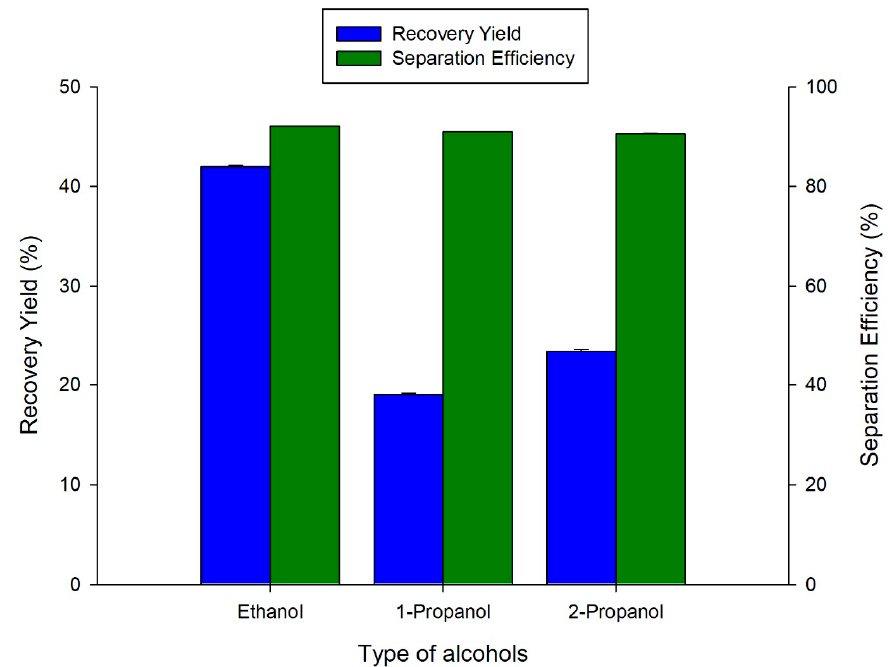
Figure 3. E ff ect of various types of alcohols on protein recovery yield and separation e ffi ciency using Figure 3. Effect of various types of alcohols on protein recovery yield and separation efficiency using LBF LBF system.